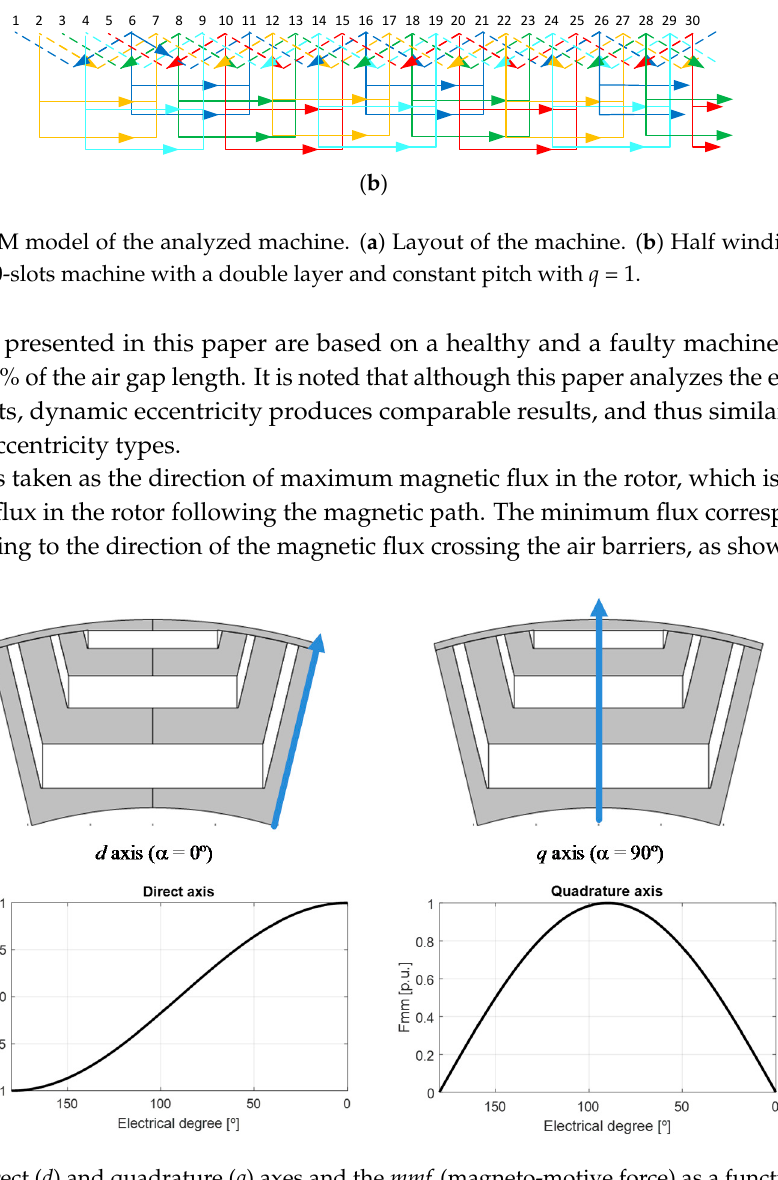
Figure 2. Direct ( d ) and quadrature ( q ) axes and the mmf (magneto-motive force) as a function of the electrical angle of a SynRM.